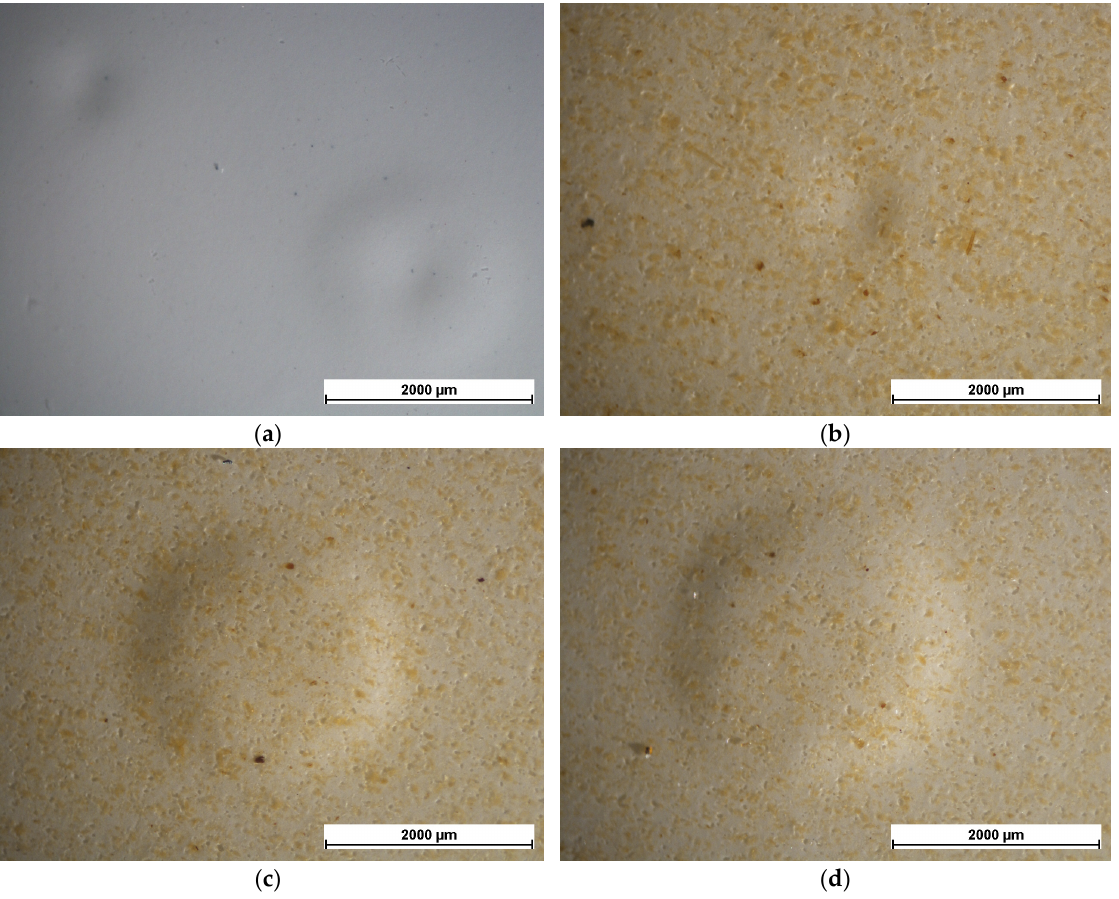
Figure 13. Blister appearance of ( a ) sample T, ( b ) sample O, ( c ) sample S, and ( d ) sample W, after 200 h of exposure to UV-B radiation.